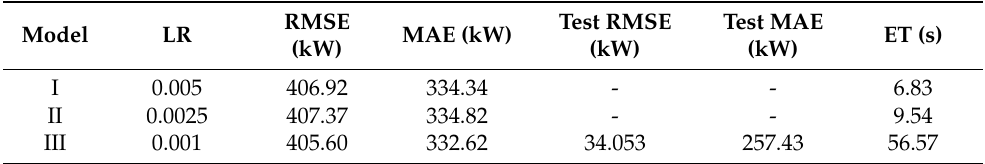
Table 9. Results of the 12-h-ahead error forecasting models.